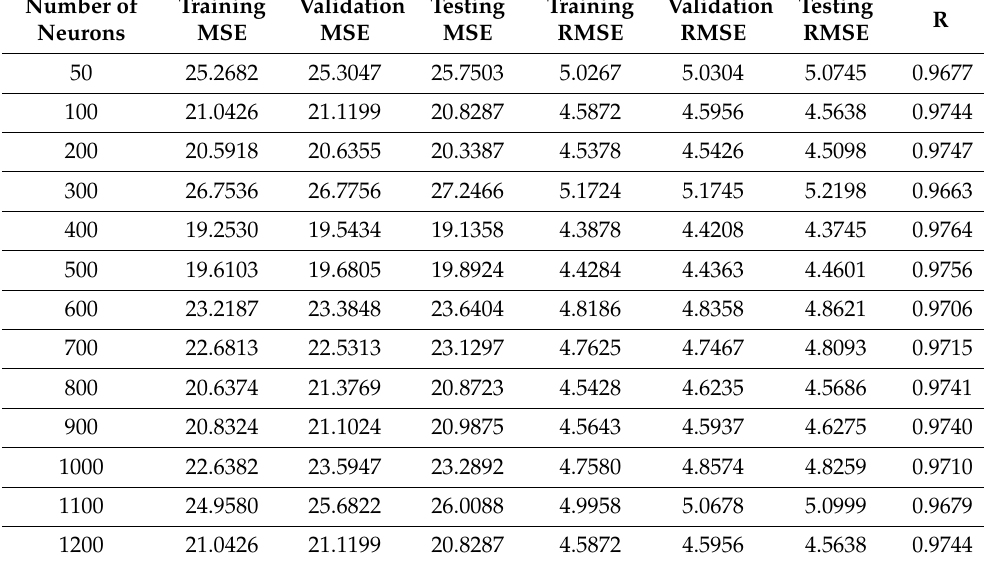
Table 3. MSE, RMSE, and R values when training the NFS model using the CGF algorithm. Number